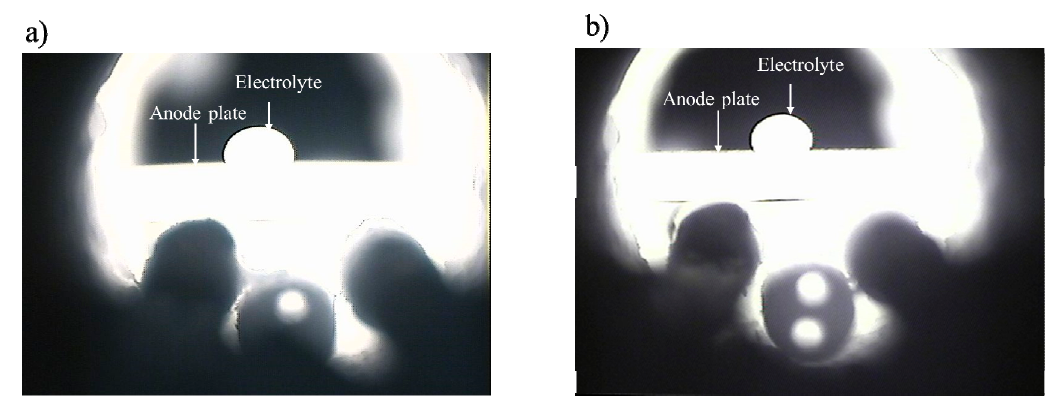
Figure 10. Wetting angles of electrolyte on anodes at 1215 K. ( a ) the carbon anode; ( b ) the graphite anode.